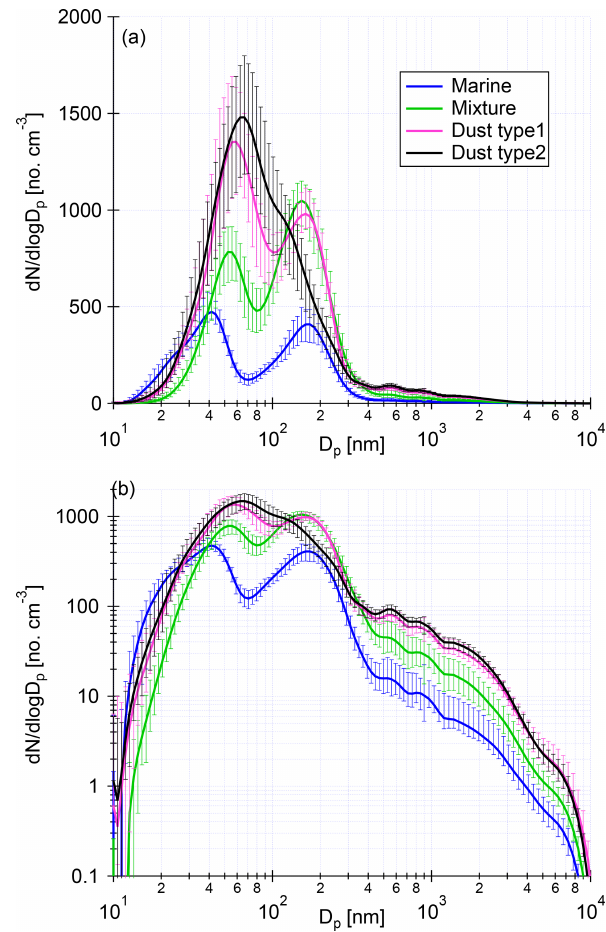
Figure 5. The median of PNSDs of marine type (blue), mixture type (green), dust type1 (purple) and dust type2 (black), with a linear (a) and a logarithmic (b) scaling on the y axis. The error bar indicates the range between 25th and 75th